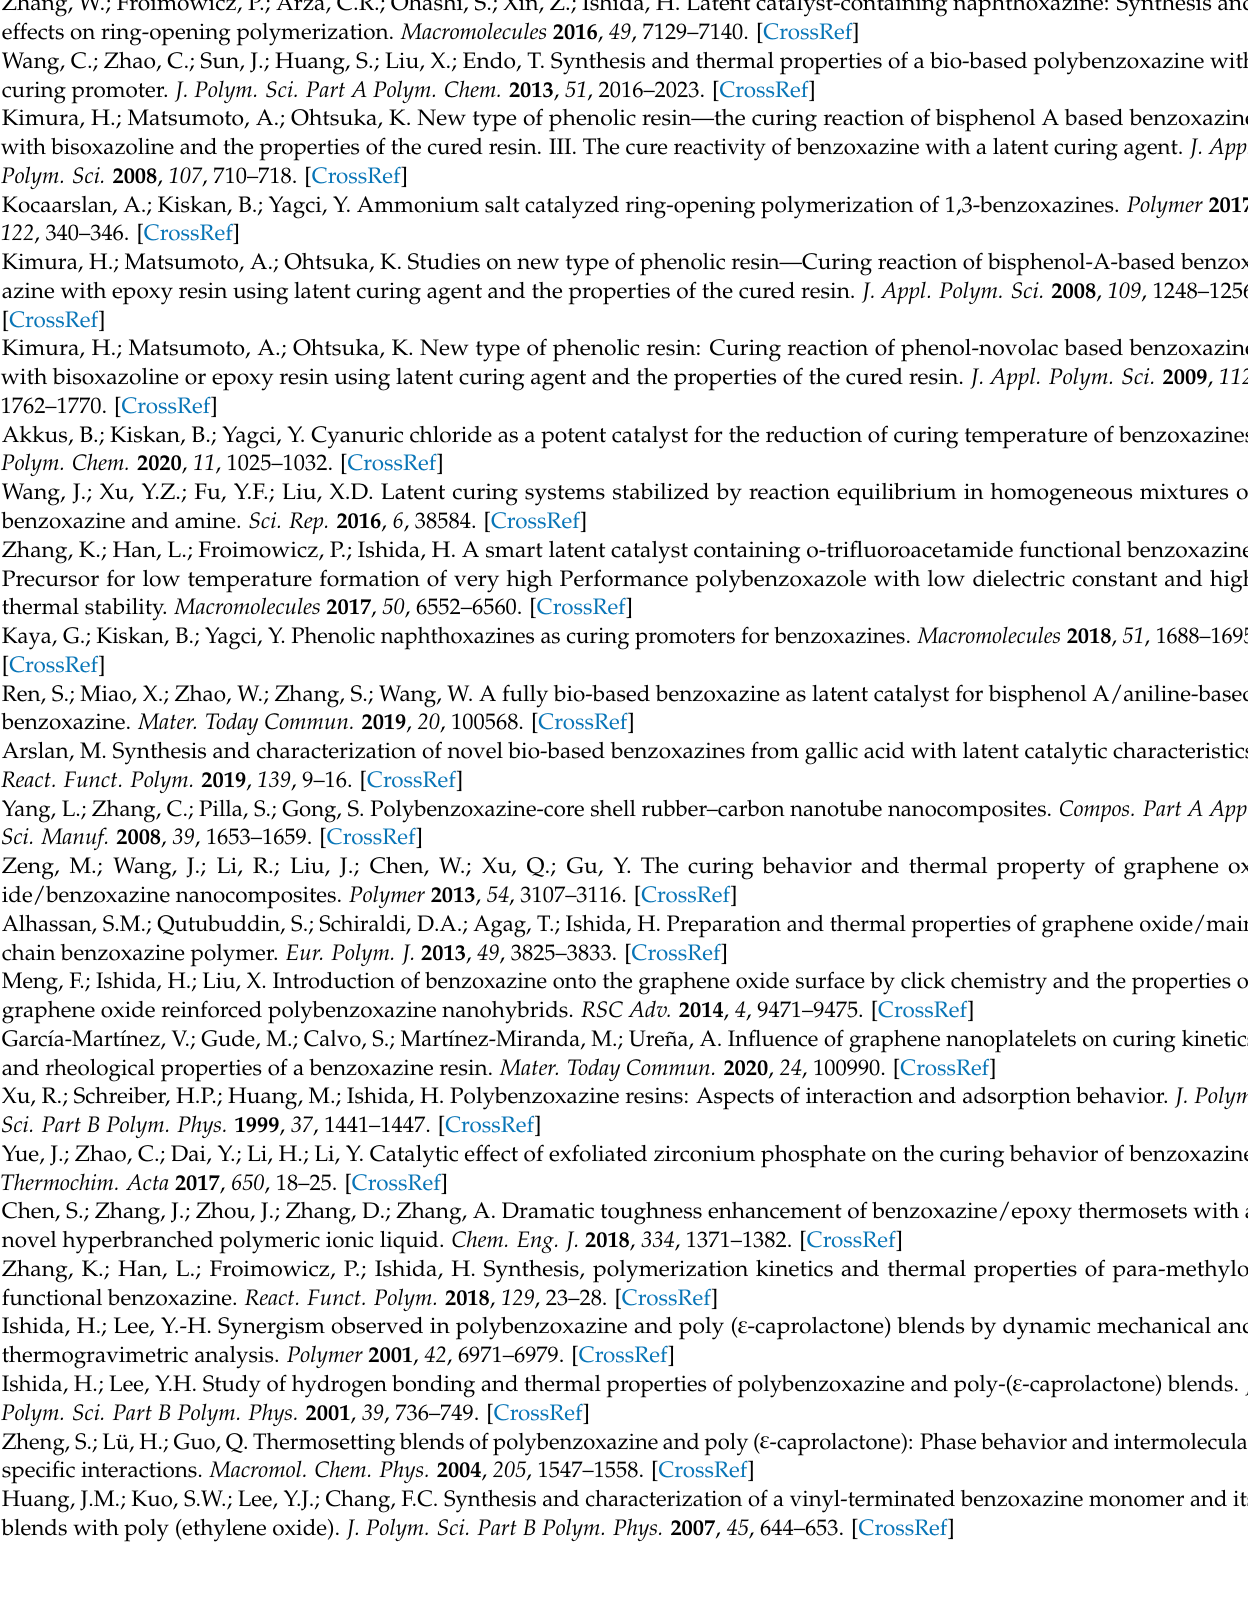
Figure 56. ( a ) Dimer 1 packing structure [80]. Copyright 2001. Reproduced with permission from American Chemical Society. ( b ) Self-termination of ring opening reaction of p -substituted phenol- based Bz [132].